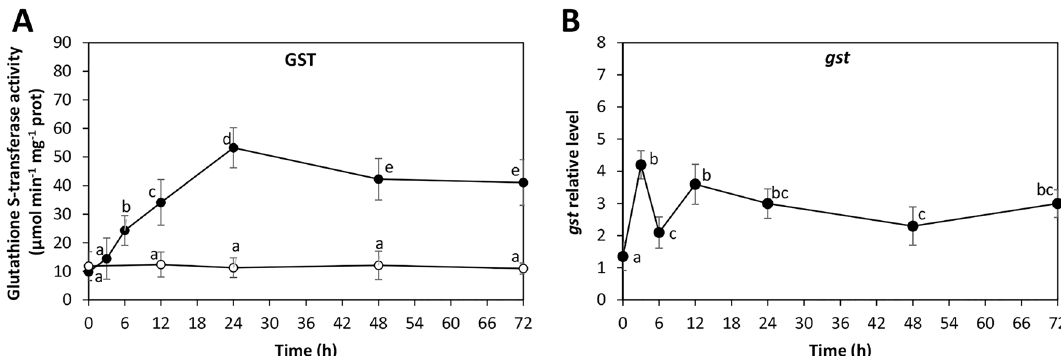
Figure 6. Activity of glutathione- S -transferase (GST, A) in U. lactuca cultivated without anthracene (open circles) and with 5 μM of ANT (black circles) for 0–72 h. The activity of GST is expressed as micromole per gram of fresh tissue (FT). Relative level of GST transcripts ( B ) in the alga cultivated with 5 μM of ANT (black circles). The relative level of GST transcripts is expressed as 2 −ΔΔCT . Symbols represent mean values of three independent experiments ± SD. Letters indicate significant differences among experiments ( P < 0.05).